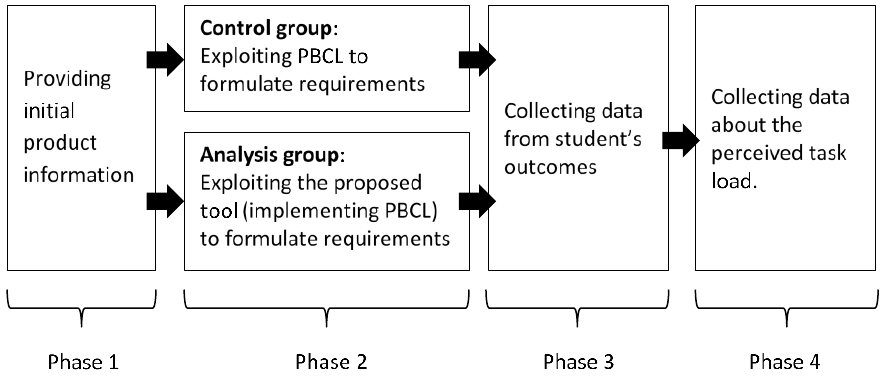
Figure 2. Schematic representation of the experimental procedure.